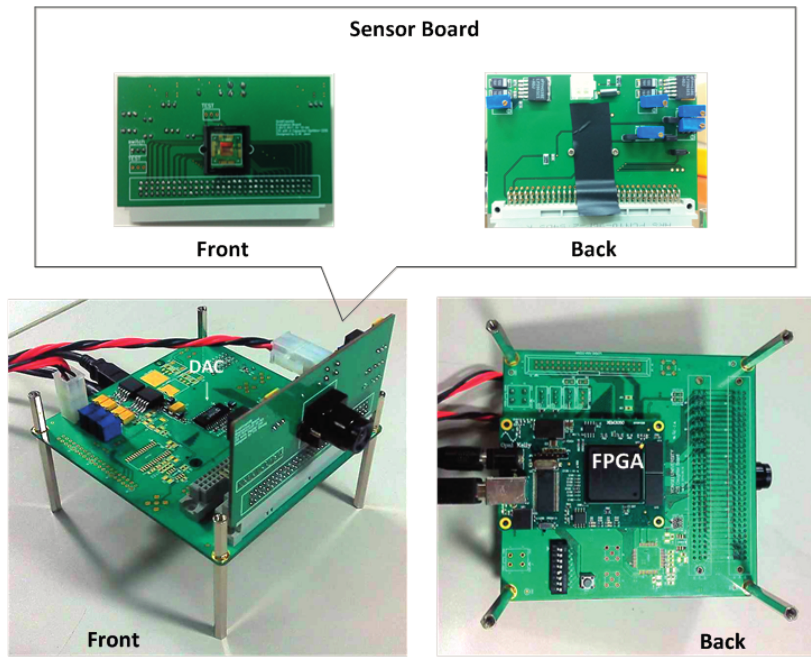
Figure 10. Photograph of the measurement system with chip on board (COB).